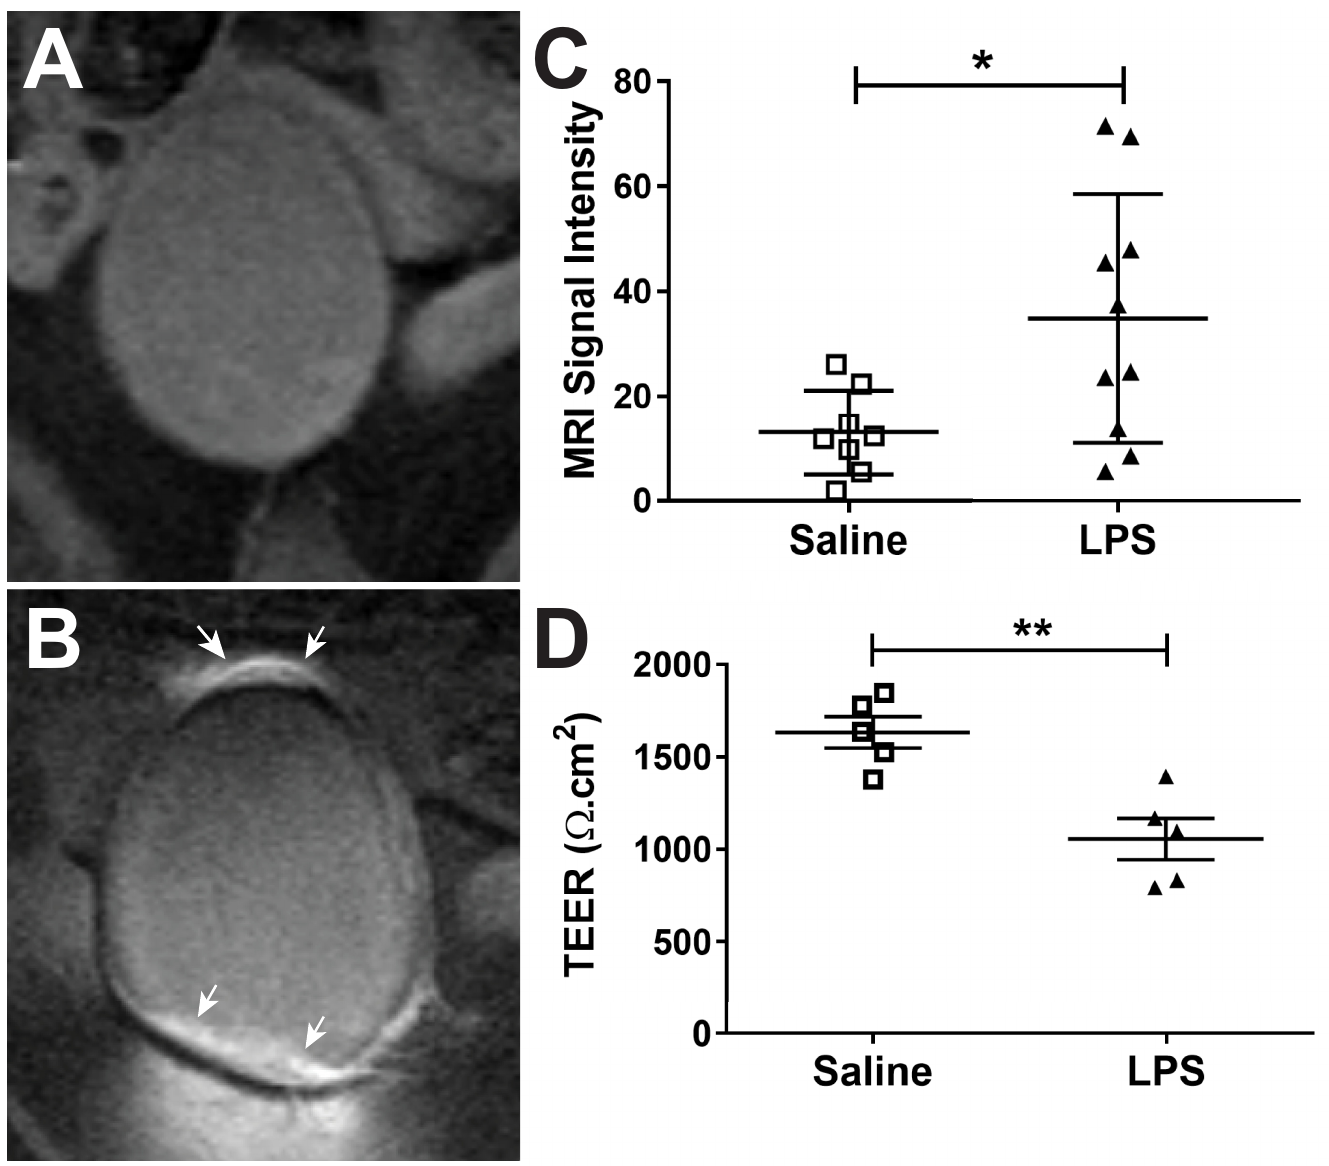
Fig 1. Bladder hyper-permeability is present in the URO-MCP-1 IC mouse model. (A, B) Representative CE-MR images of either saline- (A) or LPS-treated (B) URO-MCP-1 mouse bladders. Note hyperintense regions of the bladder in the LPS-treated mouse bladder (white arrows). (C) Percent change in MRI signal intensities outside the bladder wall after intravesical injection of MRI contrast agent, Gd-DTPA, into the bladders of saline- (open squares; n = 8) or LPS-treated (closed triangles; n = 10) mice. There was a significant increase in the percent change in MRI signal intensity in LPS-treated URO-MCP-1 mice, compared to saline-treated mice ( � p < 0.05). (D) Trans-epithelial electrical resistance (TEER) ( O .cm 2 ) of mouse bladders ( ex vivo ) that were either treated with saline (open squares; n = 5) or LPS (closed triangles; n = 5). There was a significant decrease in TEER in LPS-treated URO-MCP-1 mice, compared to saline-treated mice ( �� p < 0.01). Statistical analysis involved using an unpaired, two-tailed Student’s